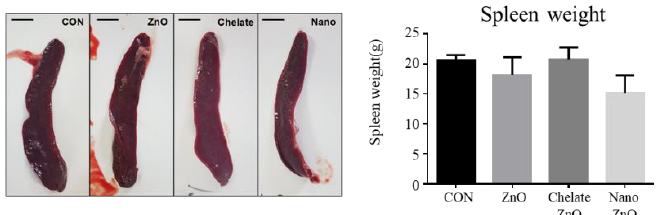
Figure 2. Spleen weights in weaned piglets fed alternative form of zinc oxide. Weaned piglets were administered different form of zinc oxide for two weeks. The control piglets were fed diets with no zinc oxide. The figure displays gross pictures and average weights of the spleen from four dietary pig groups (control, CON; ZnO, positive control; chelate-ZnO, zinc chelate with glycerin; and nano-ZnO, nanoparticle-sized zinc oxide). Data are represented as mean ± SD. Values were statistically analyzed by one-way ANOVA with Tukey’s multiple comparison test.